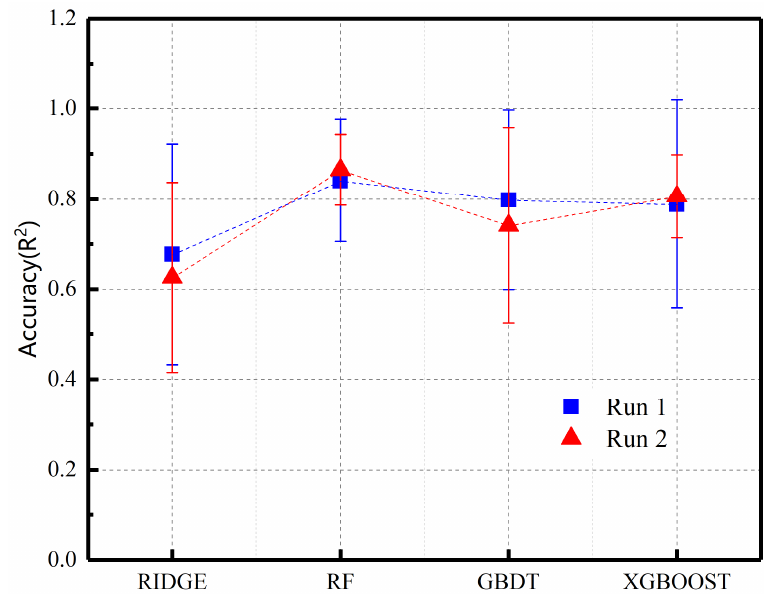
Figure 5. Cross-validation results under different machine learning in two runs.